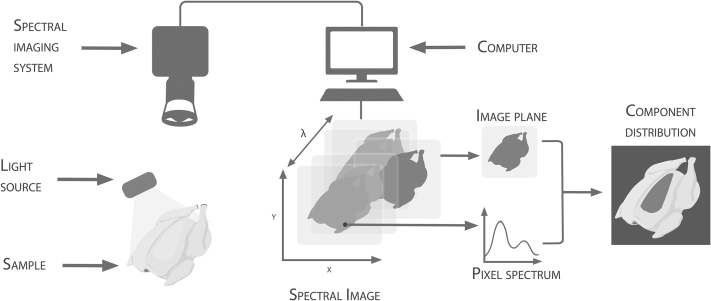
Schematic of typical HSI system hardware and workflow adapted from Boziaris (2014).